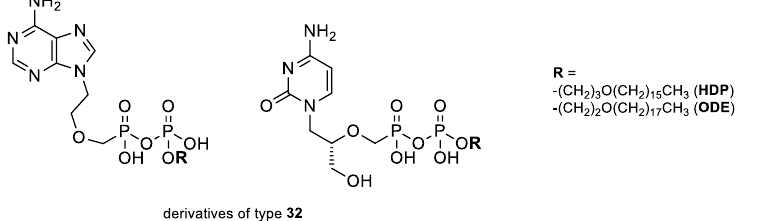
Figure 6. Lipophilic acyclic nucleoside phosphonates (ANP) analogs 32 designed by Ruiz et al. [105].